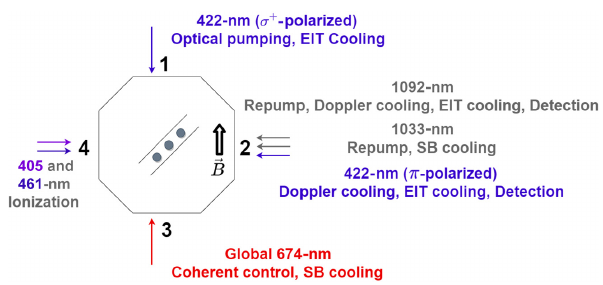
FIG. 2. Our trap is set in an optically accessible octagonal vacuum chamber. The quantization axis is defined by a pair of coils. Both a 674-nm beam, used for global coherent control and sideband (SB) cooling, as well as a circularly polarized 422- nm beam, used for optical pumping and EIT cooling, propagate along the quantization axis. 405- and 461-nm beams are used to ionize neutral Sr vapor and generate ions for trapping. 422-nm light for detection, EIT cooling, and Doppler cooling, as well as two repump lasers, enter the chamber from a single port. Not shown is the 674-nm individual addressing path, used for single- ion coherent control, which enters the chamber from a recessed window in the